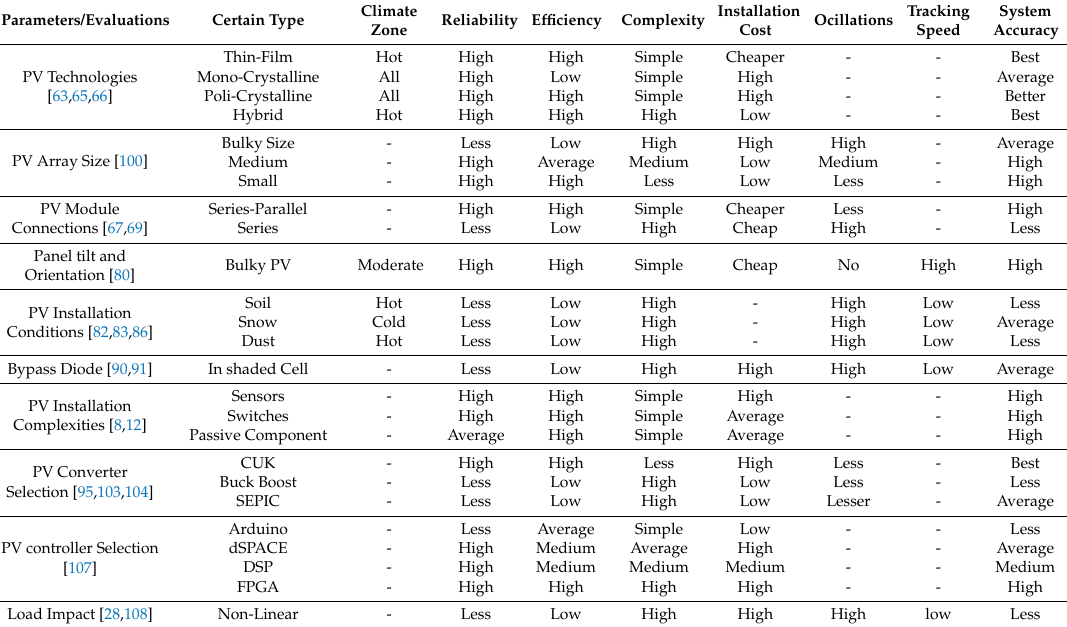
Table 4. Comparison among several evaluating parameters of the PV